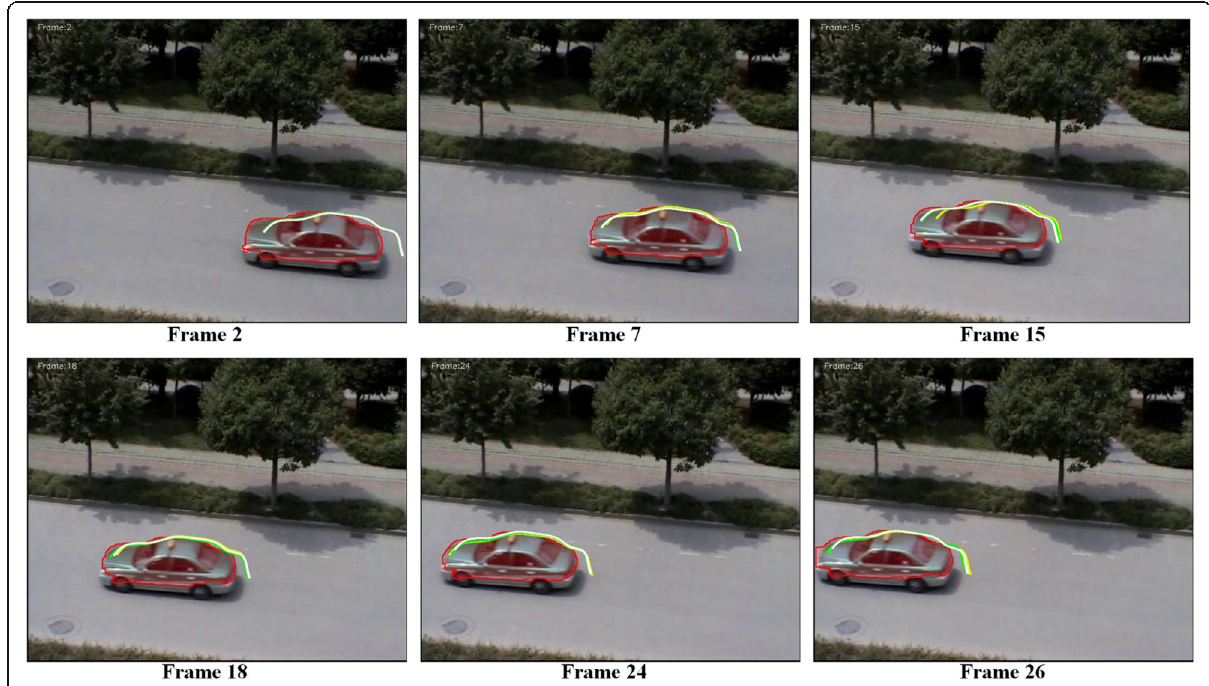
Fig. 9 Tracking result of Taxi. Yellow — UKPF, white — MHMM-UPF, red — Hough Tracker, green — proposed method